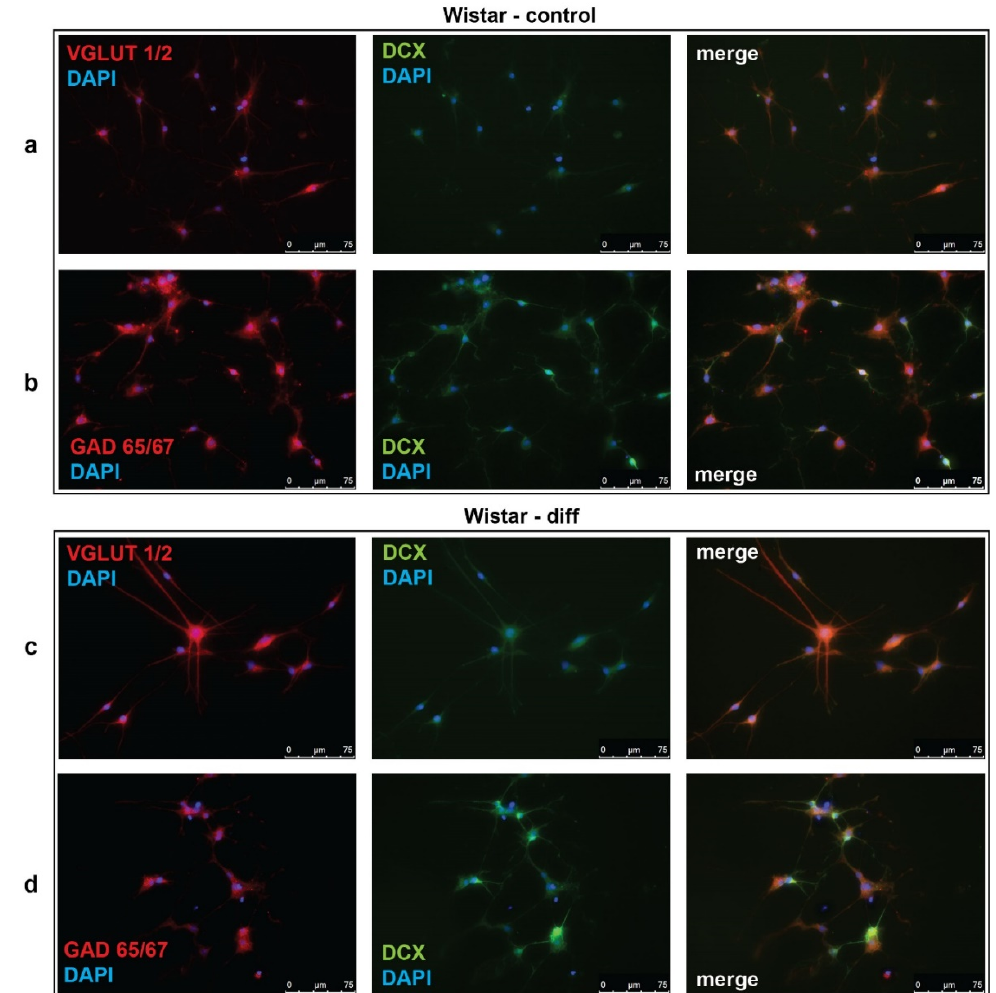
Figure 3. Representative micrographs of cultured neural progenitor cells (NPC) isolated from Wistar rat embryos. Immunofluorescent detection of VGLUT1/2, GAD65/67, and doublecortin (DCX). ( a , c ) NPC of Wistar rats were stained for VGLUT1/2 (red) or ( b , d) GAD65/67 (red) with DCX (green) in baseline conditions (Wistar-contol) and after neurotrophin-stimulated glutamatergic differentiation (Wistar-diff). Cell nuclei were stained by DAPI (blue). Merged images demonstrate cells with co-localization of VGLUT1/2 ( a , c ) or GAD65/67 ( b , d ) with DCX. Data are representative of three independent experiments.